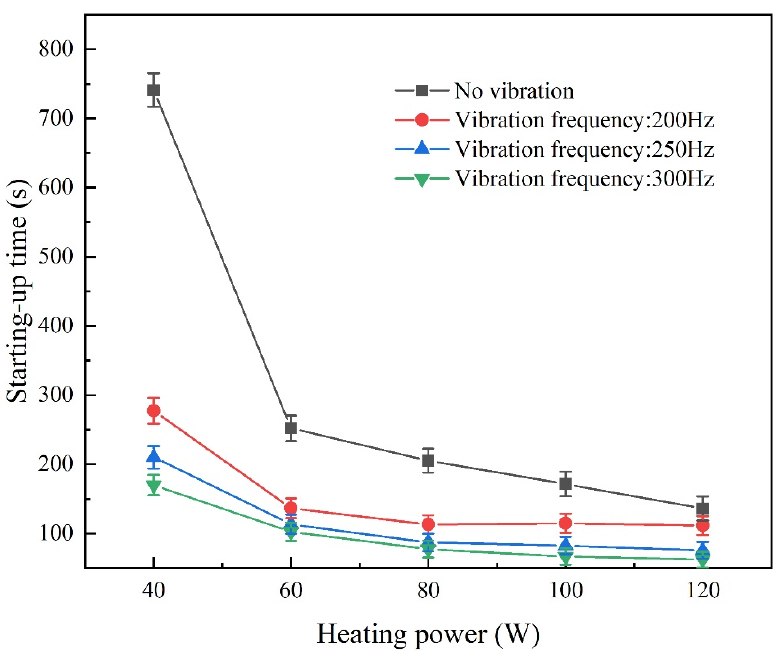
Figure 8. Influence of vibration frequency on the starting-up time of the PHP under different heating power levels (vibration on the evaporation section).